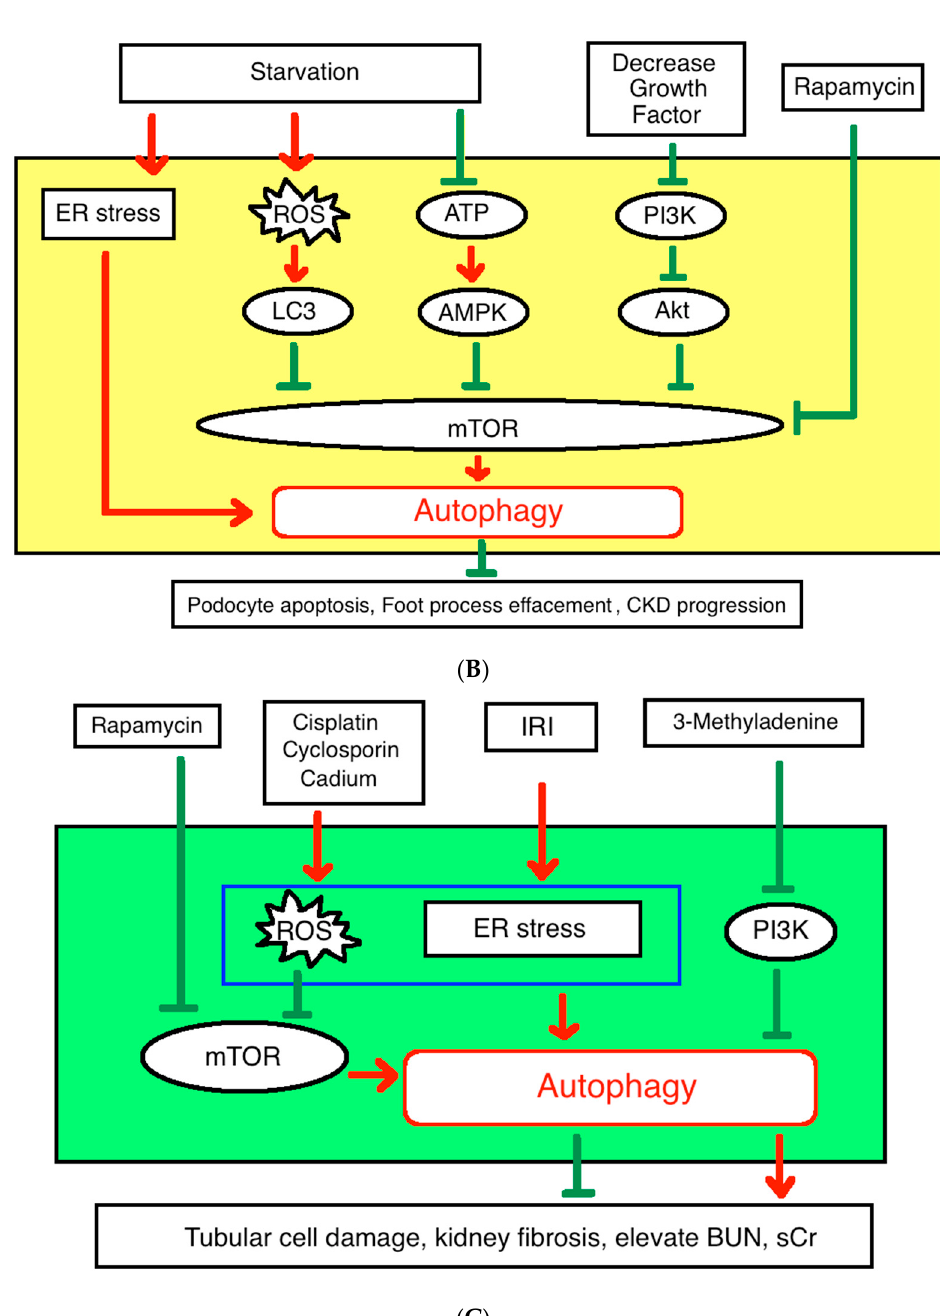
Figure 2. ( A ). Autophagy in glomerular mesangial cells. AGEs: advanced glycation end-products; Akt: also stand for PKB (Protein kinase B); GSK-3 β : glycogen synthase kinase-3 β ; PI3K: Phosphoinositide 3-kinase; ROS: reactive oxygen species; TGF- β 1: transforming growth factor- β 1; ER stress: endoplasmic reticulum stress; ( B ). Autophagy in podocytes. PI3K: Phosphoinositide 3-kinase; AMPK: AMP-activated protein kinase Akt: also stand for PKB (Protein kinase B); ROS: reactive oxygen species; ER stress: endoplasmic reticulum stress; ( C ). Autophagy in proximal tubular cells. IRI: ischemic reperfusion injury; ROS: reactive oxygen species; ER stress: endoplasmic reticulum stress; PI3K: Phosphoinositide 3-kinase; BUN, blood urea nitrogen; sCr, serum creatinine.